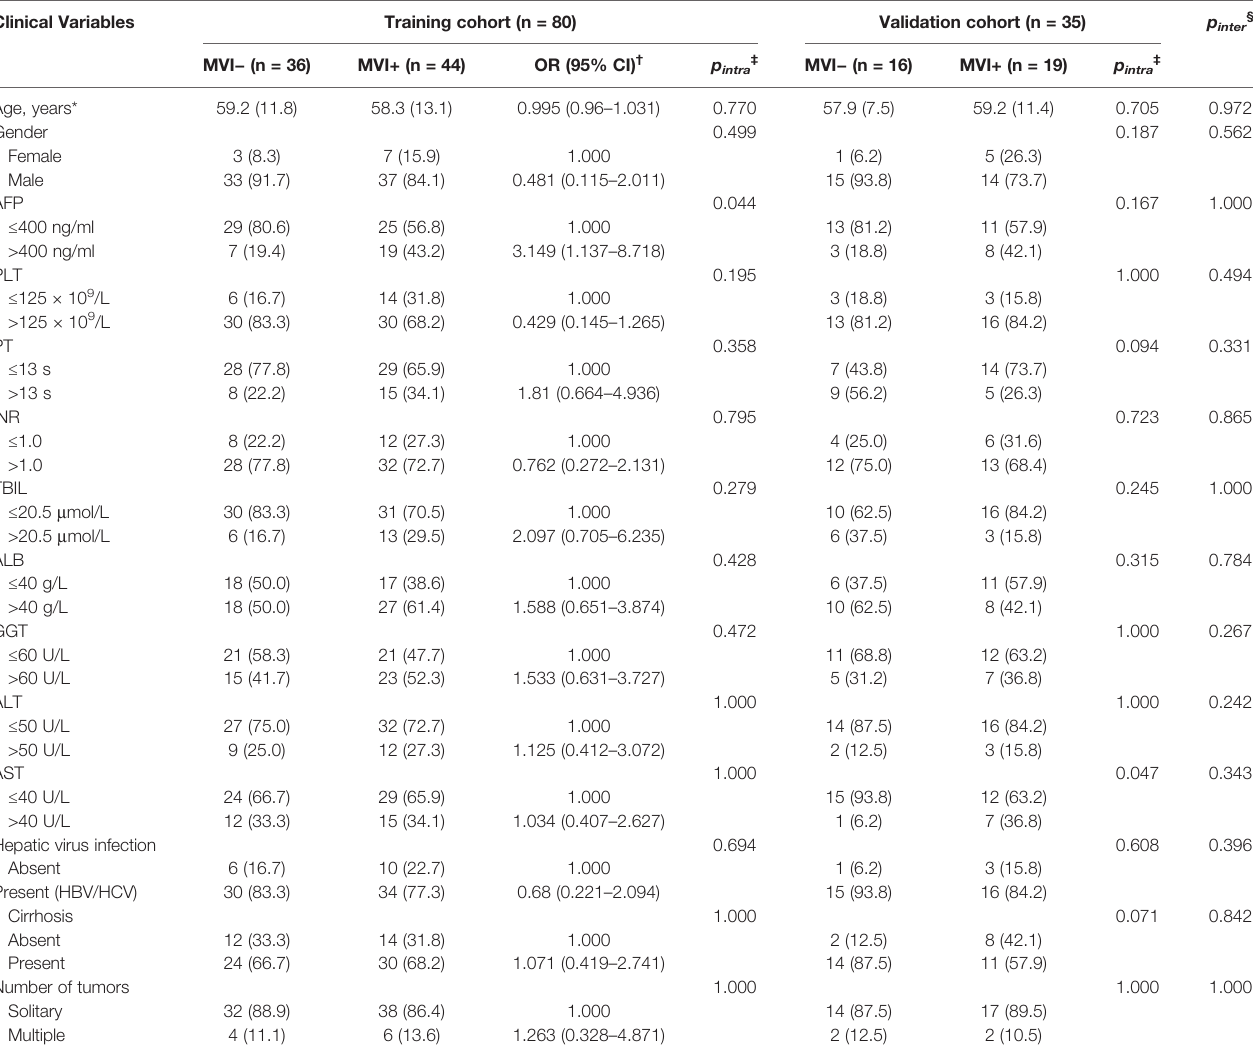
TABLE 1 | Clinical characteristics in the training and validation cohorts. Clinical Variables Training cohort (n = 80) Validation cohort (n =